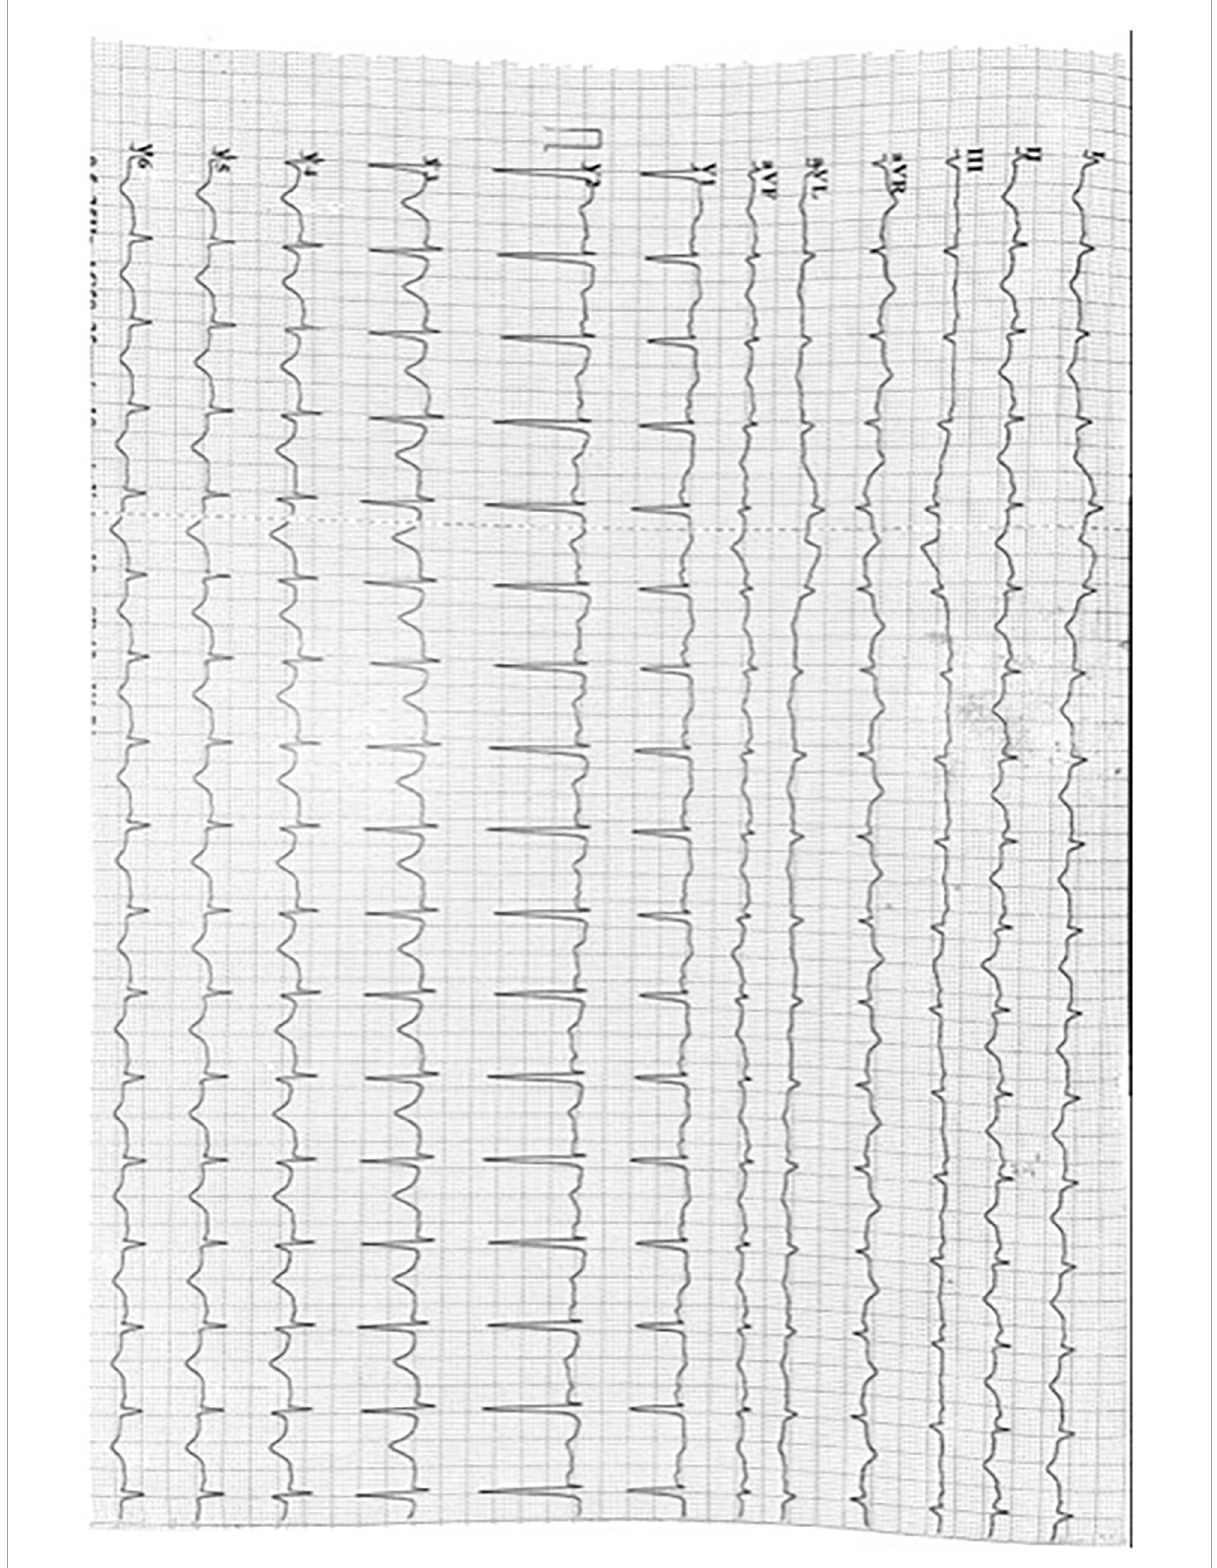
FIGURE2 Electrocardiogram series. Shows electrocardiogram at day 2 since TTS diagnosis: A slight ST segment elevation (1 mm) in V1 is added compared with previous